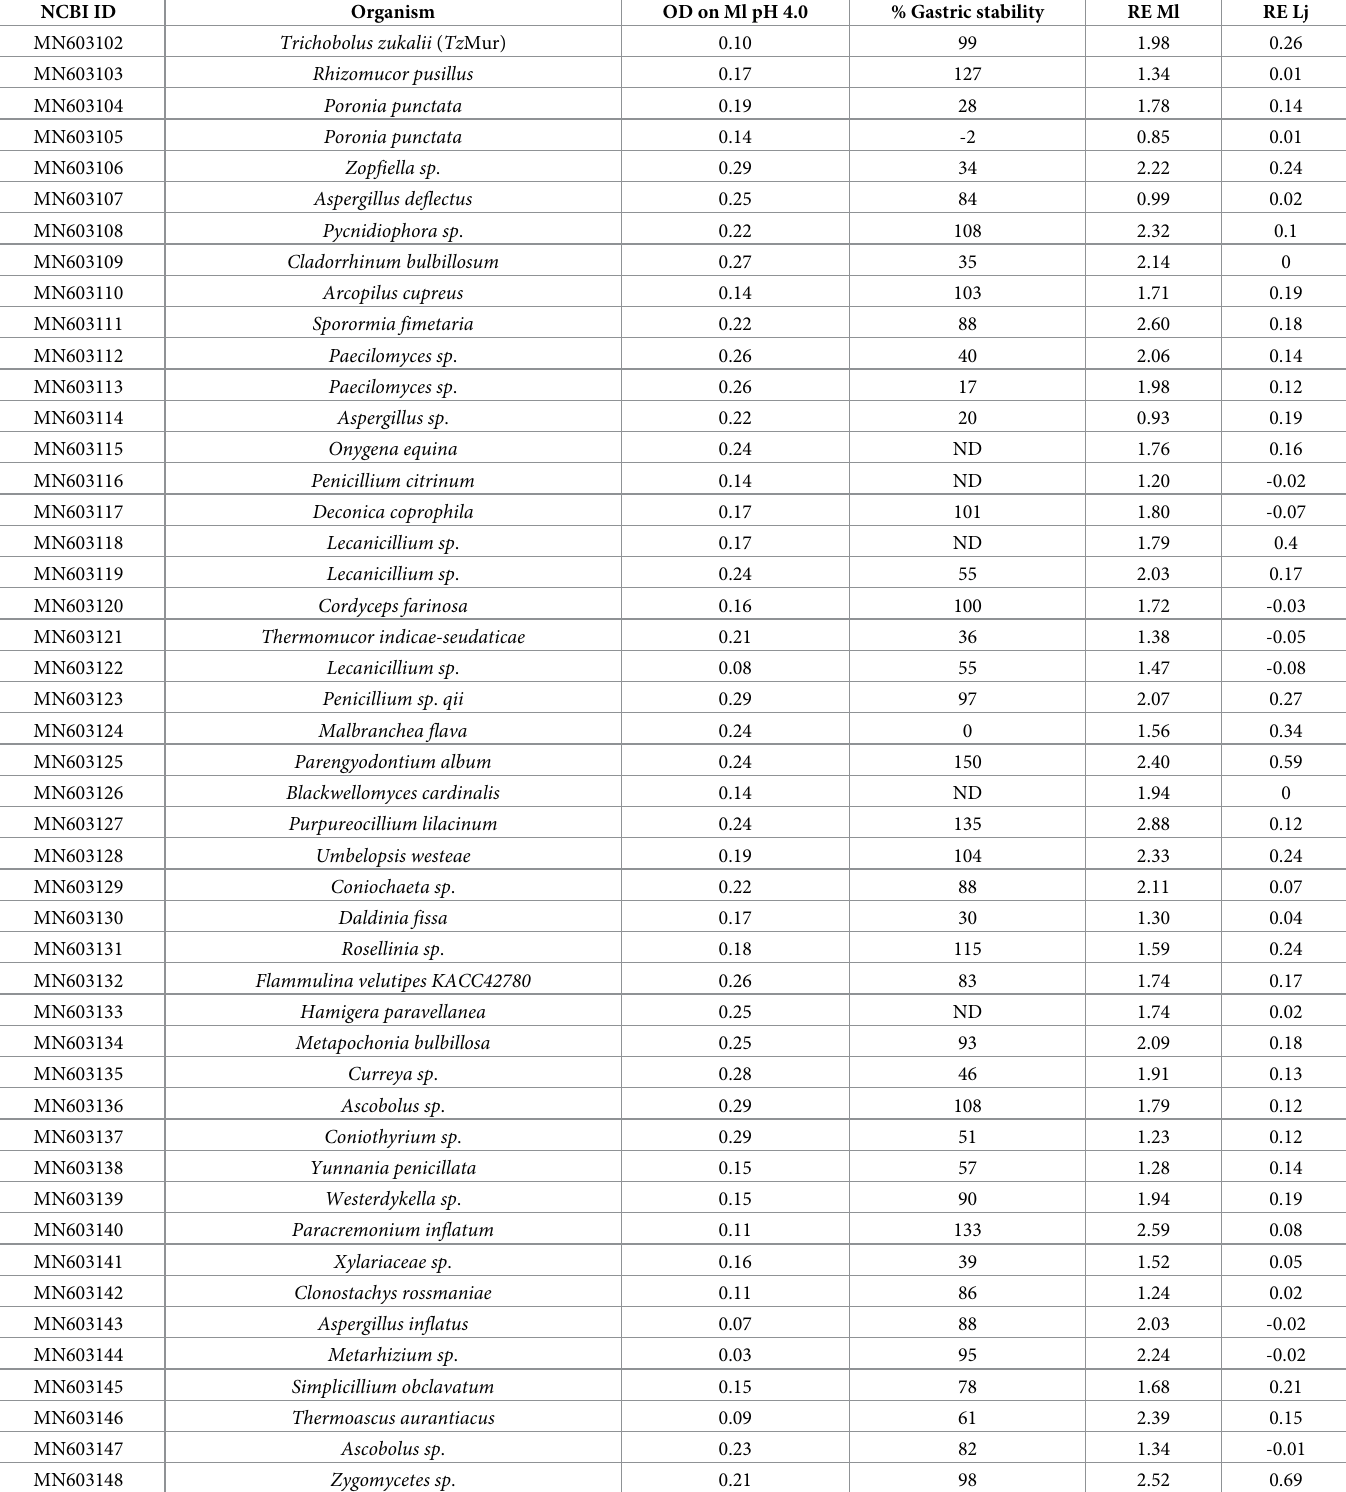
Table 3. The screening results for the 55 fungal